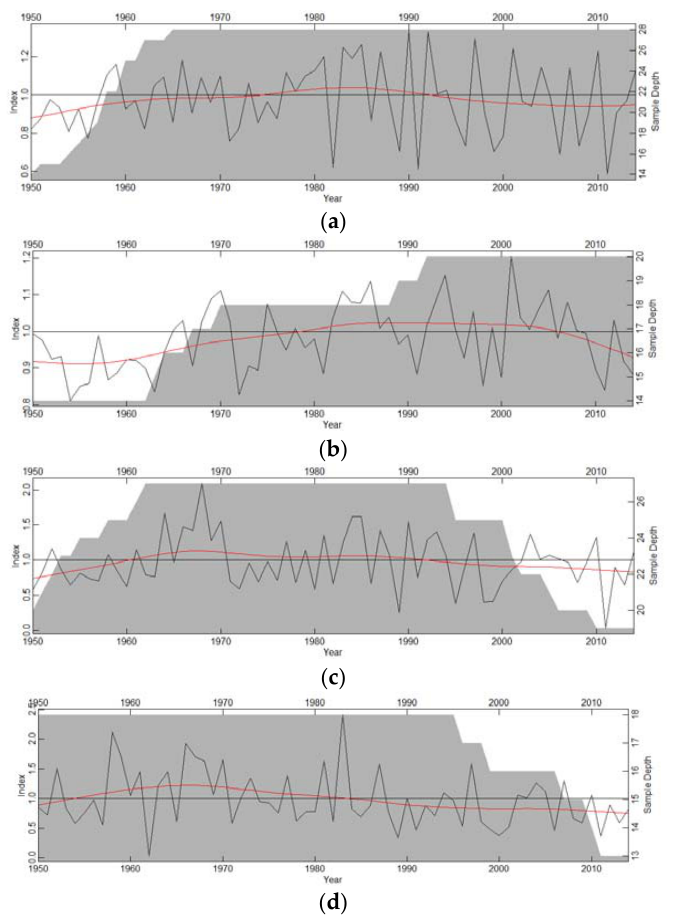
Figure 2. Residual chronologies of ring ‐ width indices (black lines) of ( a ) A. durangensis ; ( b ) C. lusitanica ; ( c ) P. engelmannii ; and ( d ) P. cembroides . The red lines show moving averages and the grey areas indicate the number of measured radii (sample depth) for each year (right y ‐ axis).